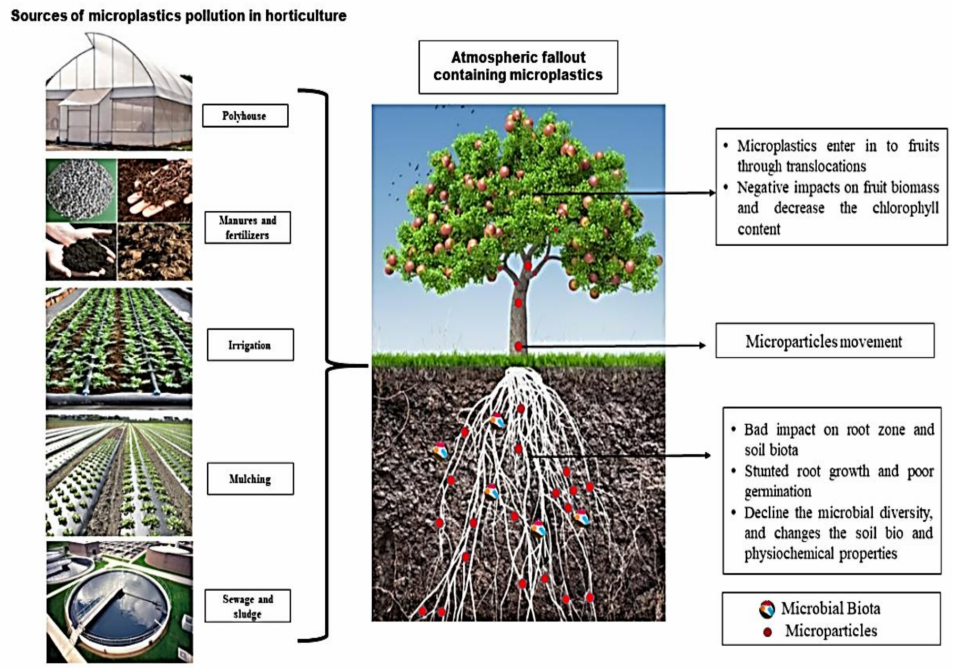
Figure 4. Possible sources and their effect on crops, soil, and